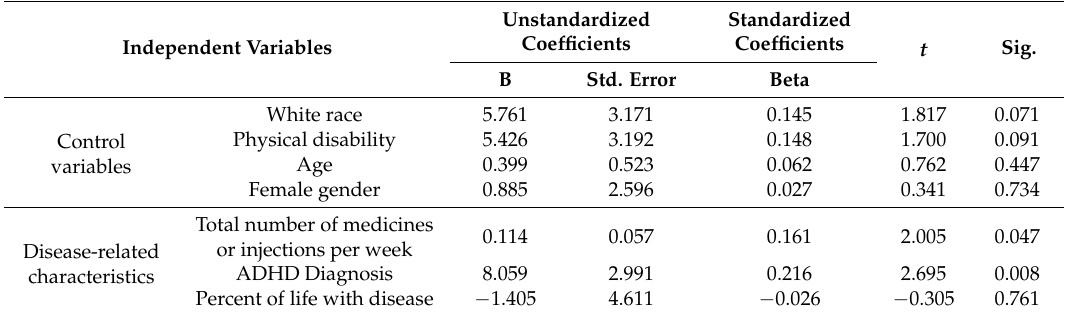
Table 2. Predicting caregiver burden by disease-related characteristics (Model R 2 = 0.130).